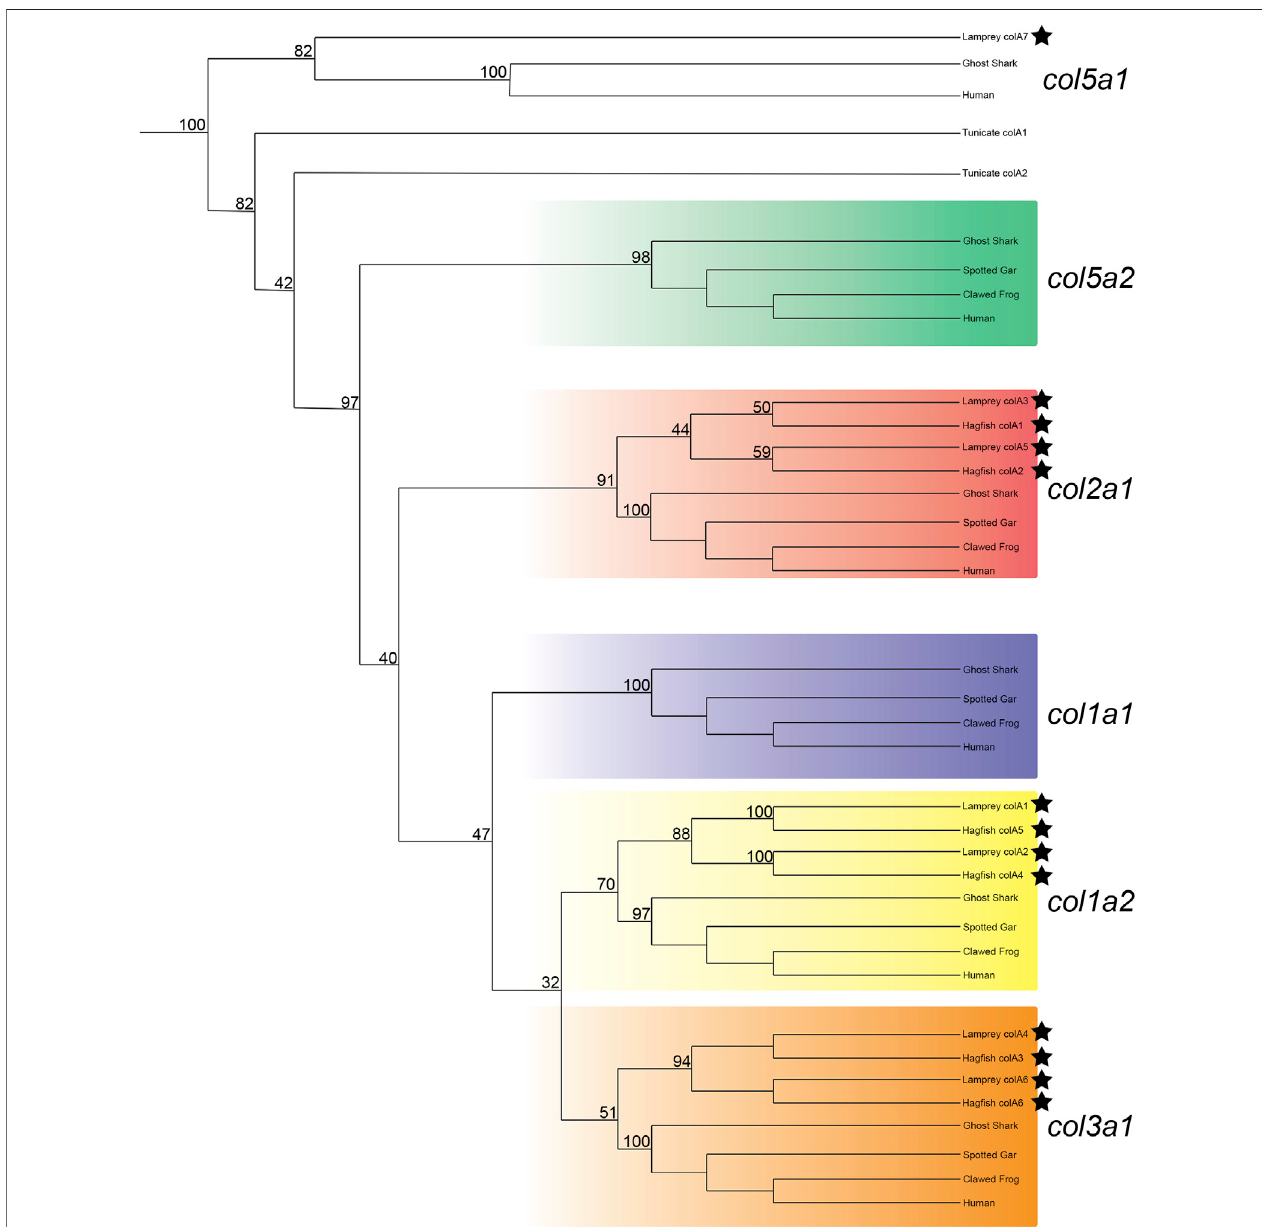
FIGURE 1 | Recreated phylogenetic tree built from vertebrate and tunicate Clade A fi brillar collagen sequences. Maximum likelihood analysis scores are shown at therespectivenode.Thehumanandghostshark col5a1 geneswerechosenasthemostrelevantoutgroup.Cyclostomegenesarelabelledwithablackstar.Originaltree can be found in Supplementary Figure S3 . Accession numbers for all sequences can be found in Supplementary Table S3 .